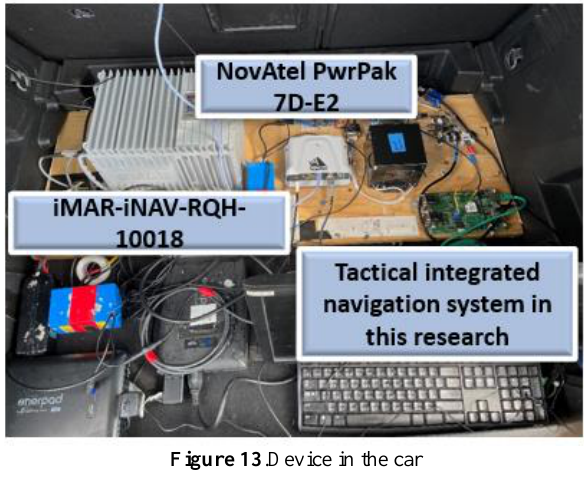
Figure 13 .Device in the car